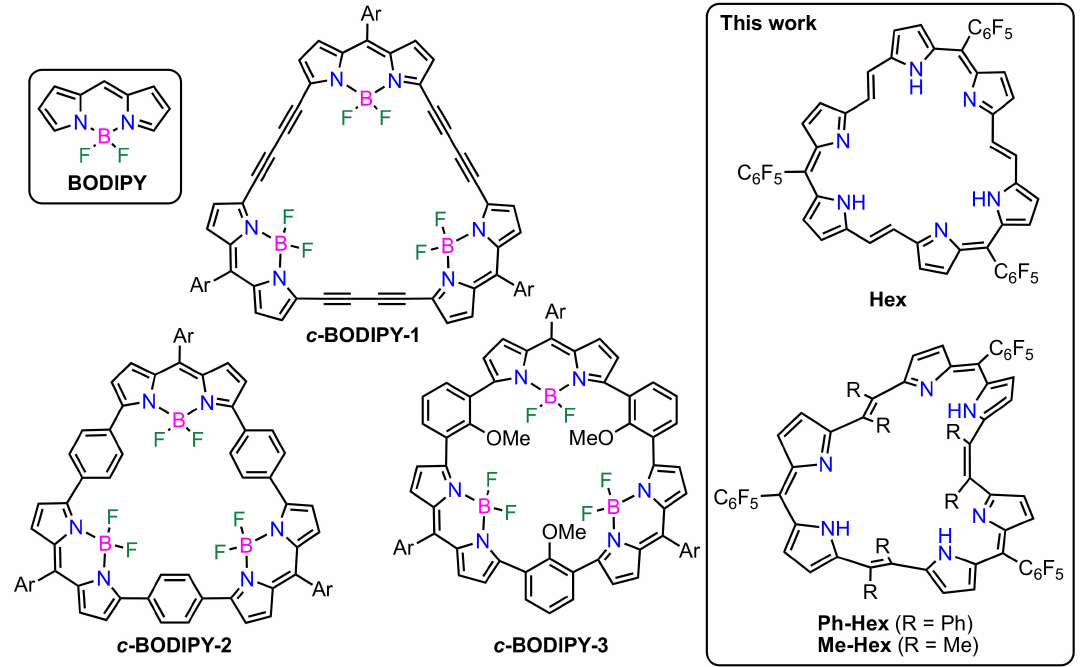
Figure 1. Chemical structures of boron–difluoride complex of dipyrrin (BODIPY) and cyclic BODIPY trimers with various linkages, and expanded porphyrins Hex, Ph-Hex, and